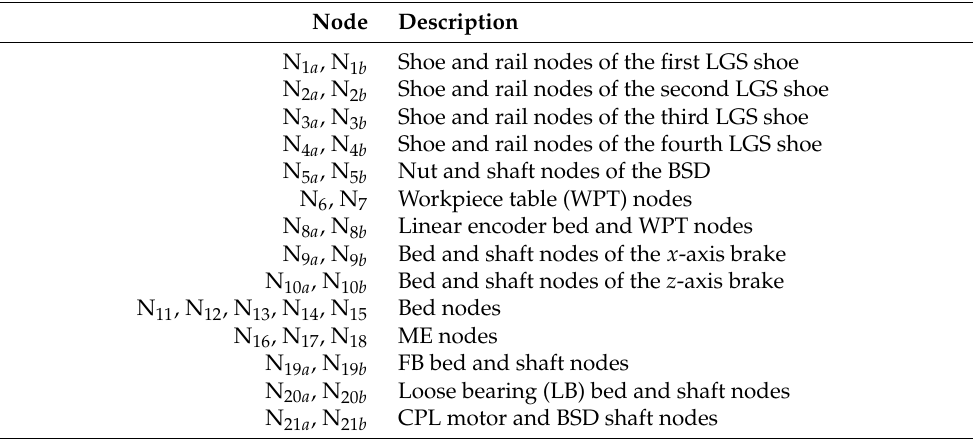
Figure 4. Illustration of a four-axis machine tool model in uniaxial configuration, consisting of a machine bed and a workpiece table (WPT); the non-hidden nodes (see Table 1) considered in the identification are indicated by circular markers. Table 1. Considered model nodes; overlapping nodes are indicated by alphabetic